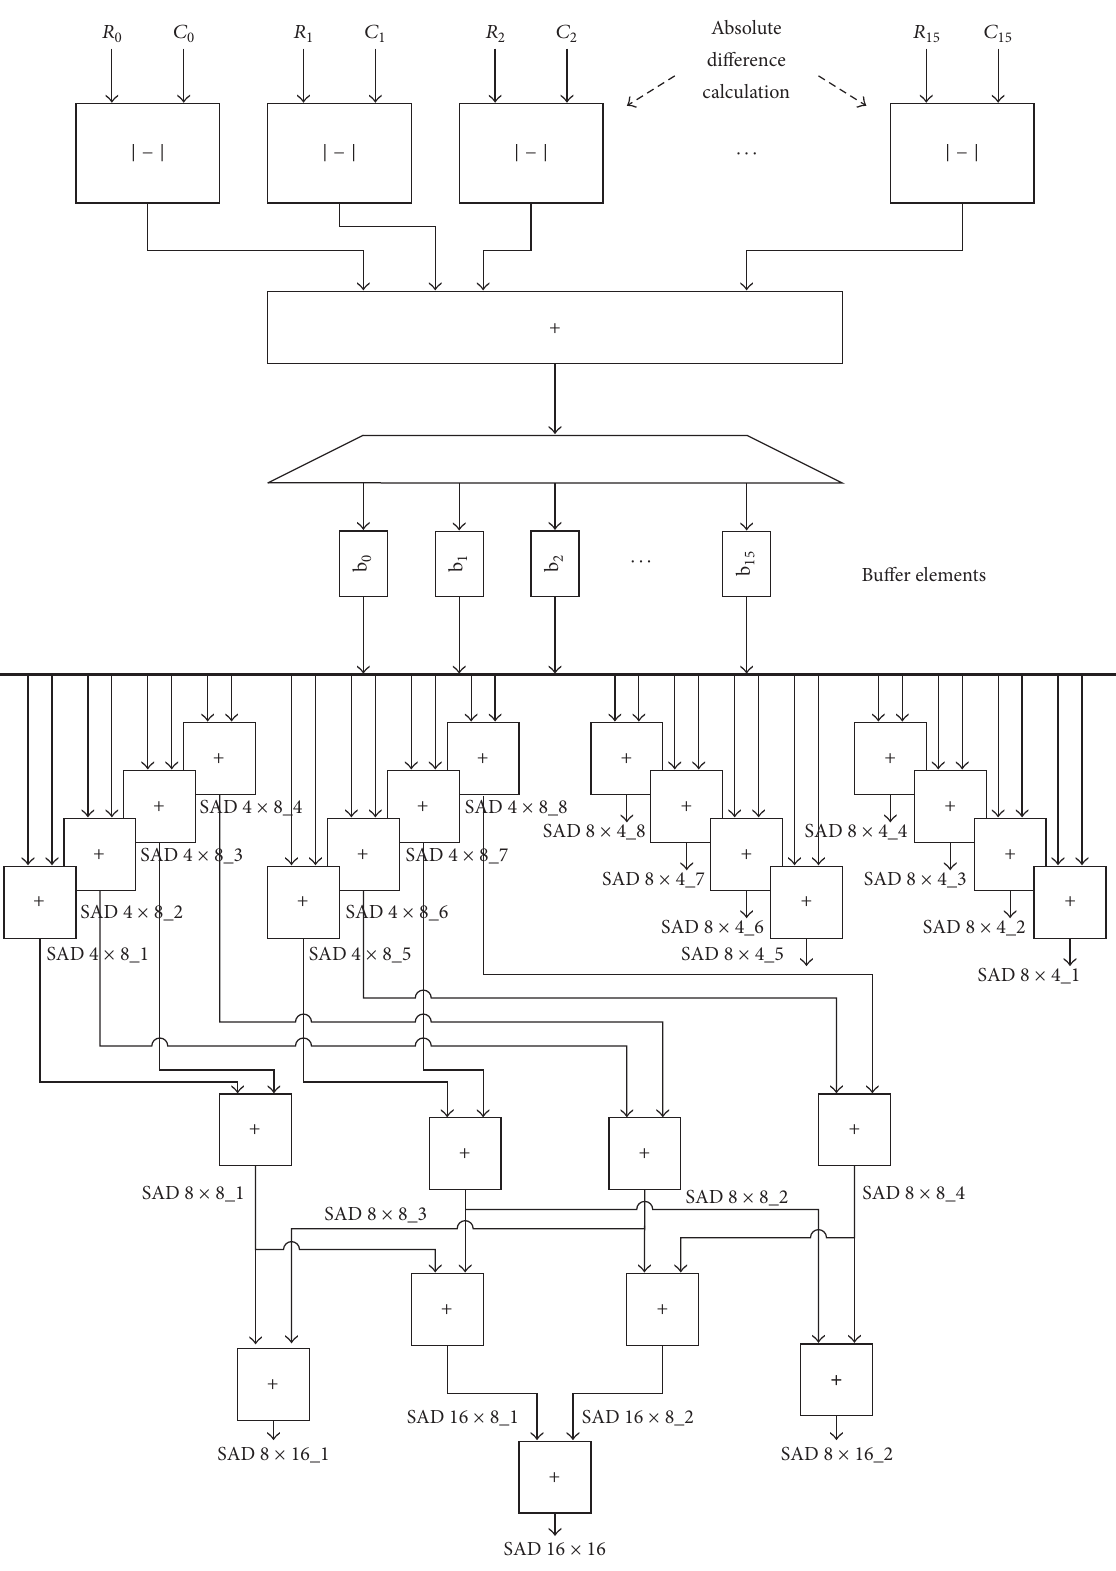
Figure 7: Detailed PE